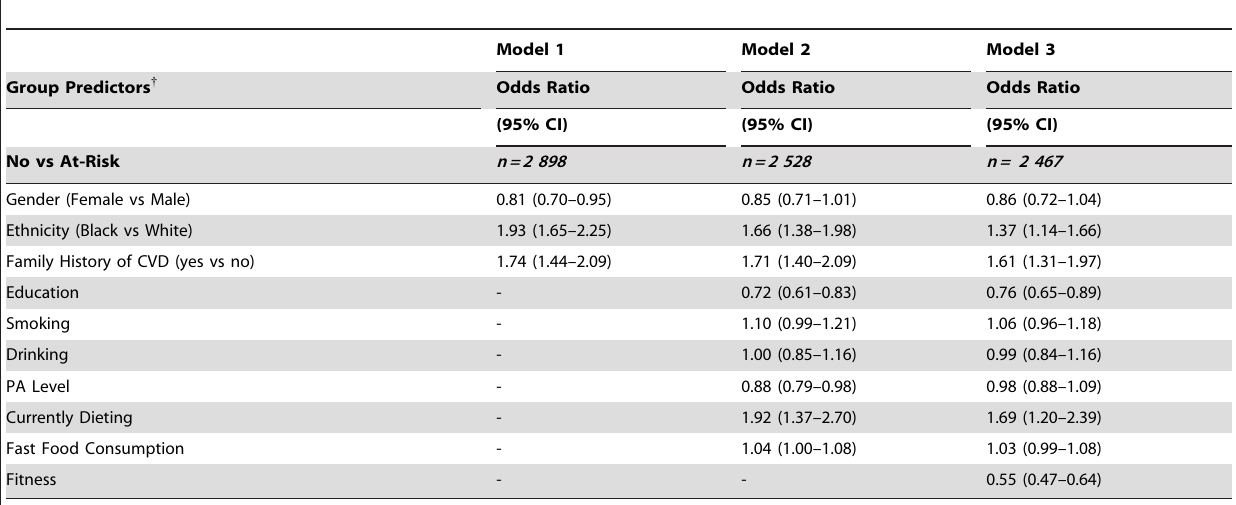
Figure 4. Evolution of individual MetS Components based on trajectory groups (No, Low, Mod and High). doi:10.1371/journal.pone.0111647.g004 Table 2. Baseline Predictors of Higher Trajectory Group